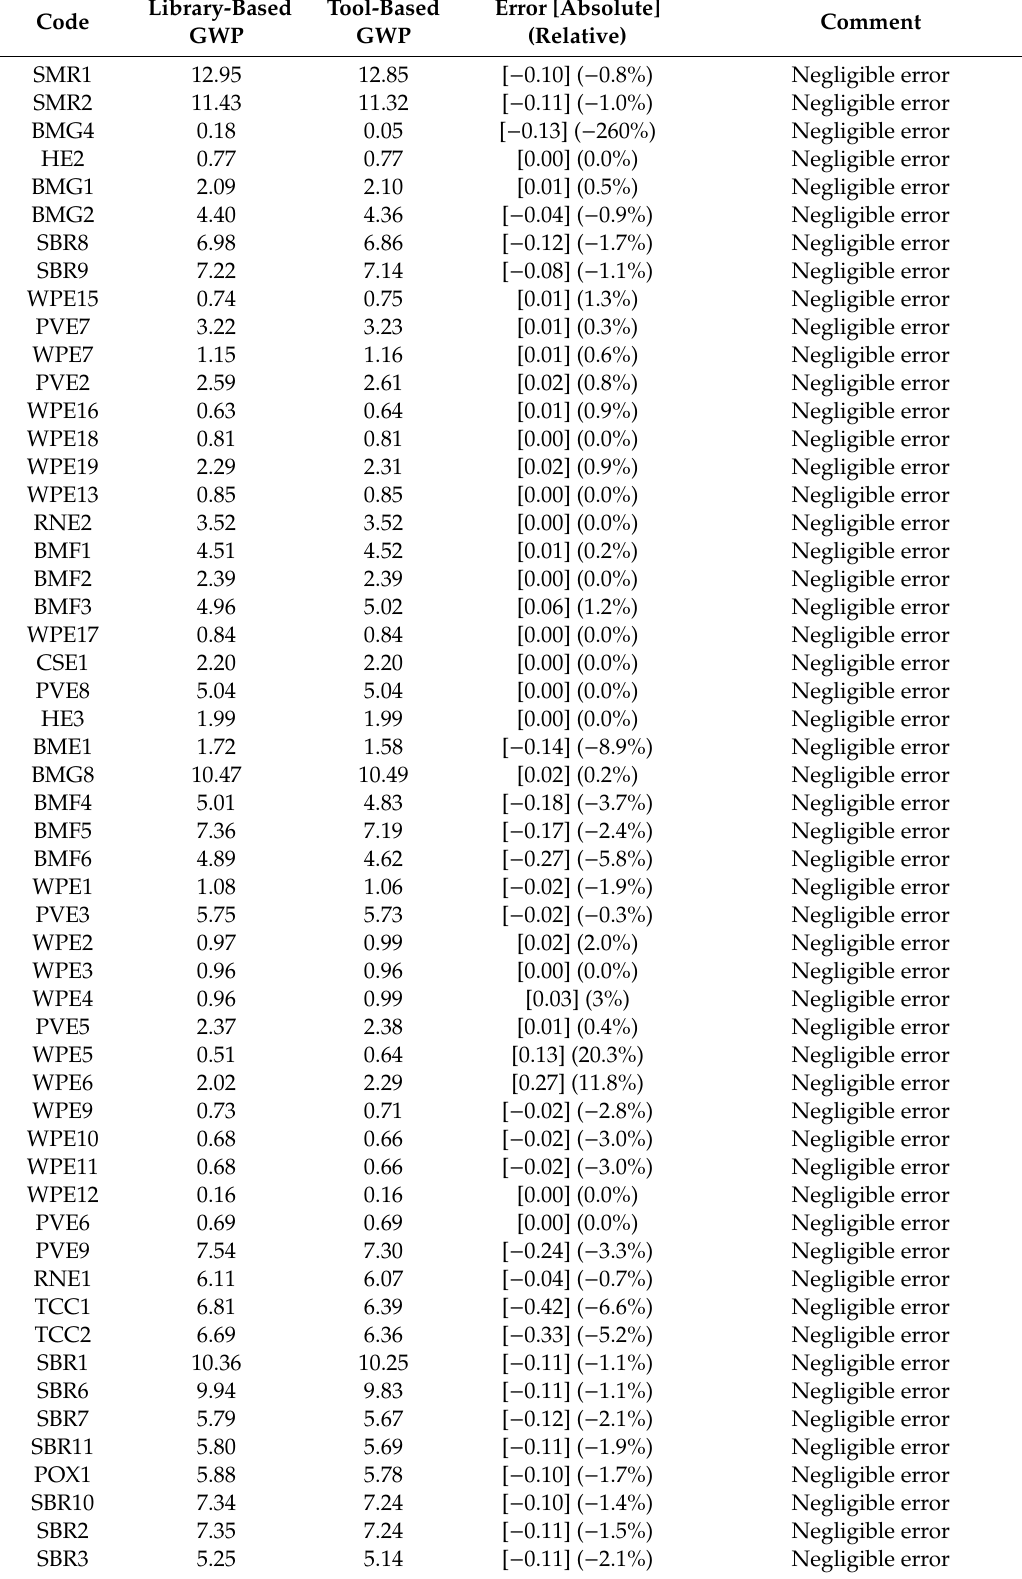
Table 1. Library- and tool-based harmonised carbon footprints of hydrogen (kg CO 2 eq per functional